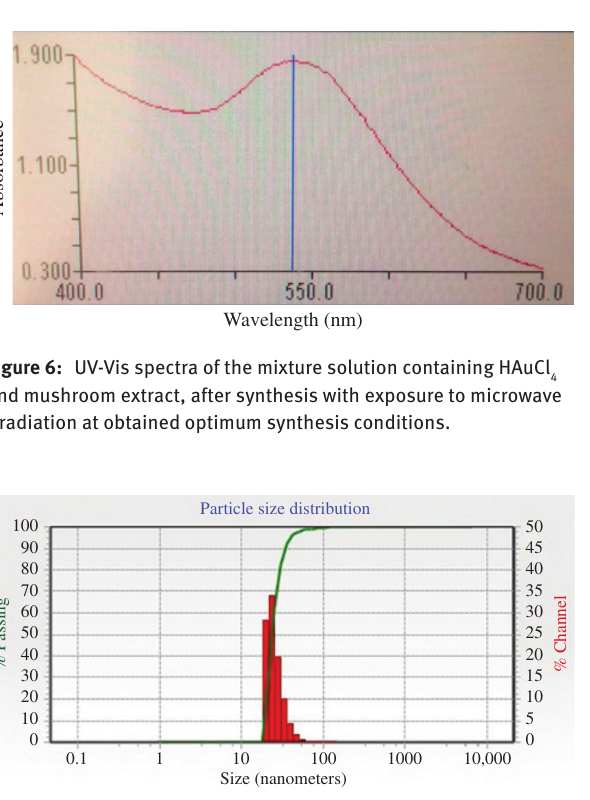
Figure 7: Dynamic light scattering (DLS) of the synthesized